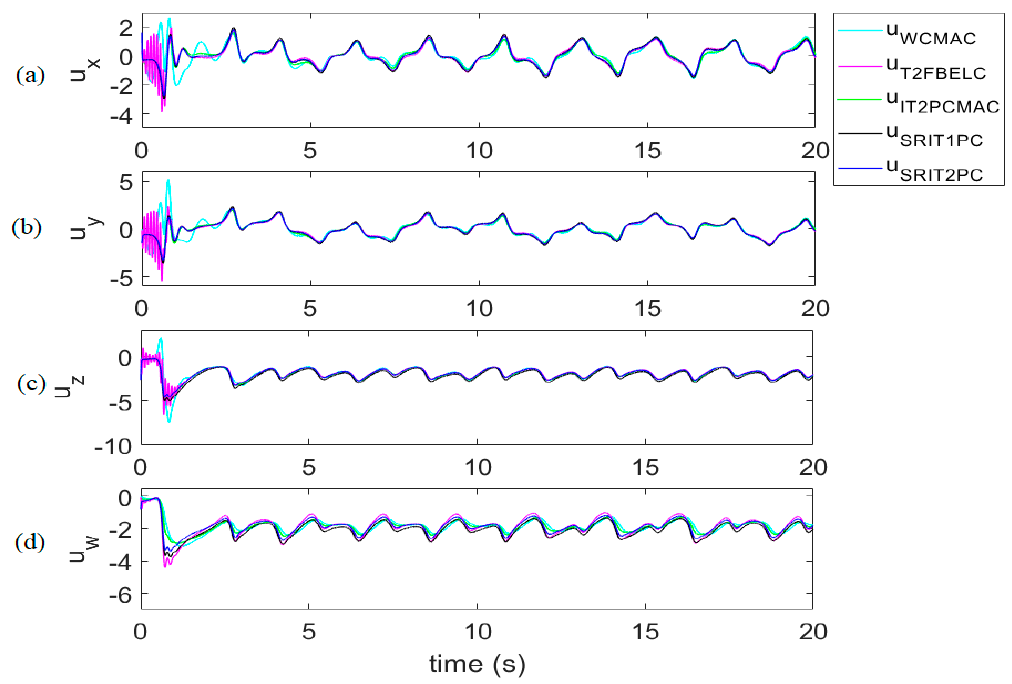
Figure 19. Control signals between the proposed SRIT2PC and other synchronization methods for Case 3: ( a ) u x , ( b ) u y , ( c ) u z , and ( d ) u w .